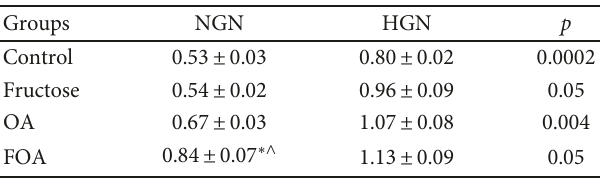
Figure 6: Intima media of the Aorta. HE (10x). (a) NGN control. (b): NGN FOA. (c) HGN control. (d) HGN FOA. Table 6: Arteriole media/lumen (M/L)